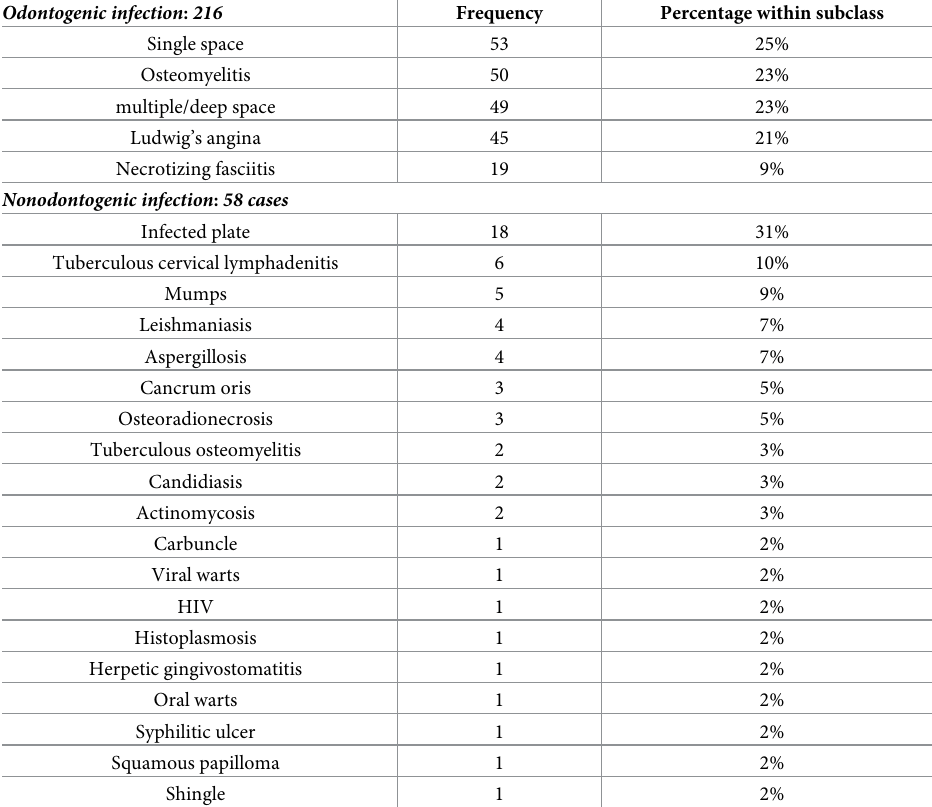
Table 8. Frequency of 274 infections.